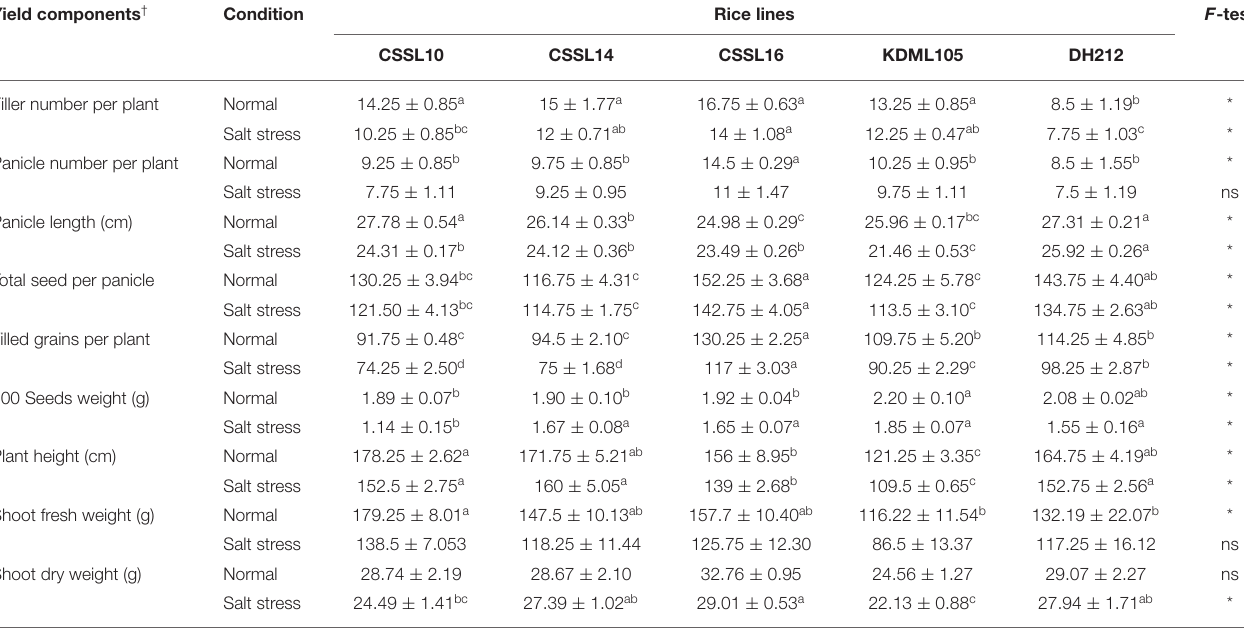
† Values are represented as mean ± SE (n = 4). Different letters indicate significant difference between lines at p < 0.05. “ns” indicates no significant difference. * Significant difference at p < 0.05. downregulated. When the plants were exposed to salt